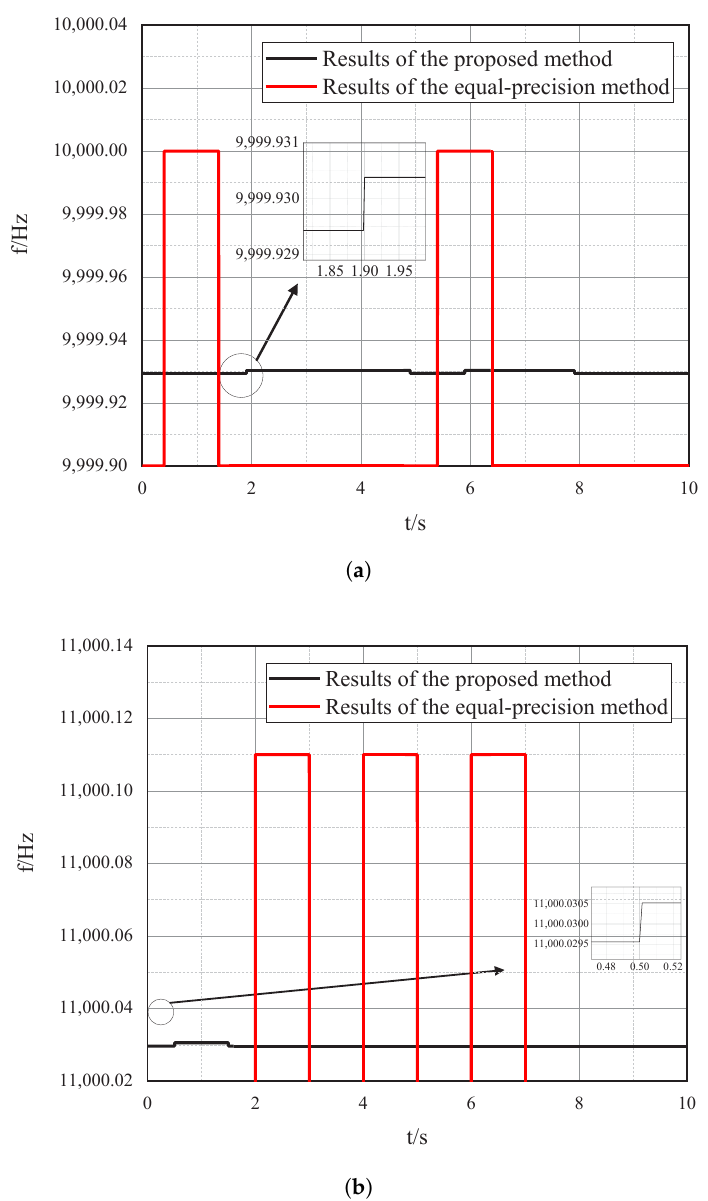
Figure 11. Simulation results of the proposed method and the equal-precision measurement method: ( a ) Tested signal: f x = 9999.930 Hz. ( b ) Tested signal: f x = 11,000.030